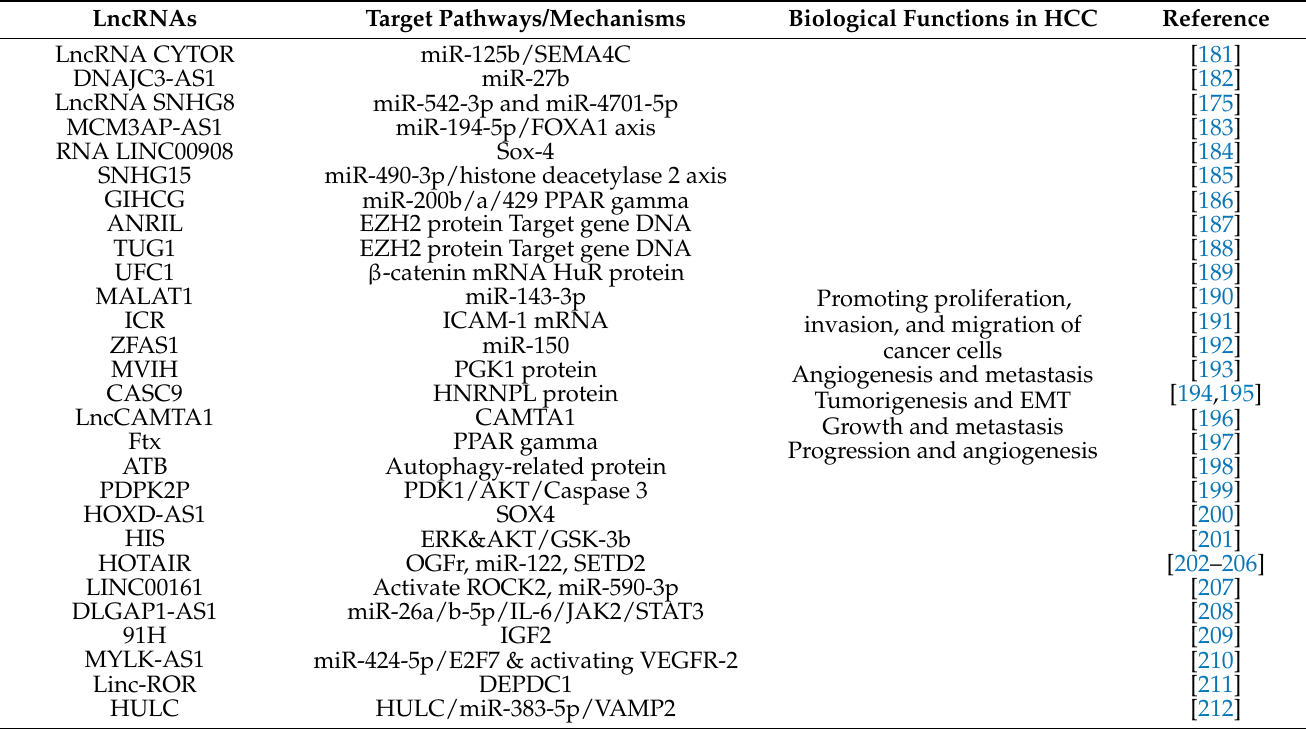
Table 2. Biological functions of lncRNAs in hepatocellular carcinoma